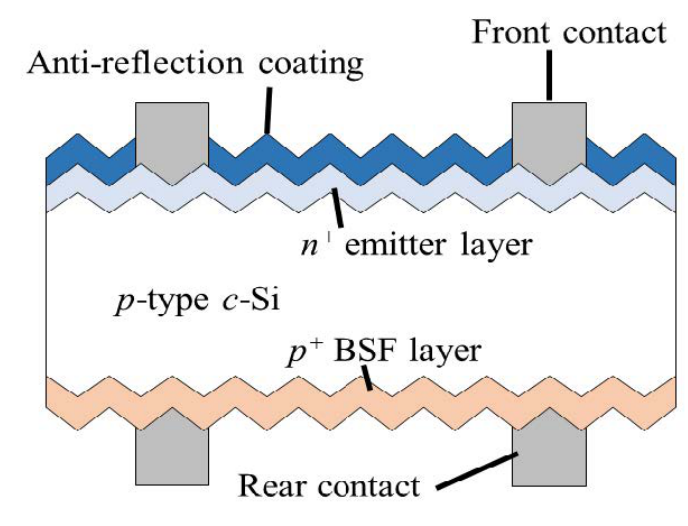
Figure 1. Silicon solar cell structure used for this